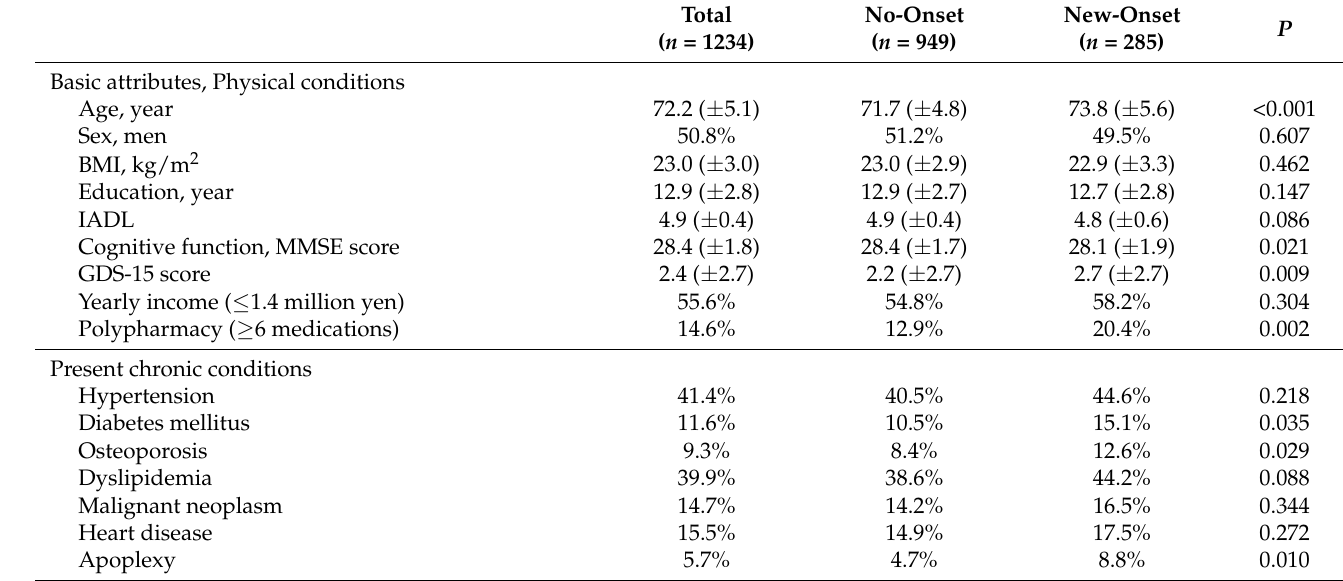
Table 1. Comparison of basic characteristics at baseline with and without new-onset of oral frailty.